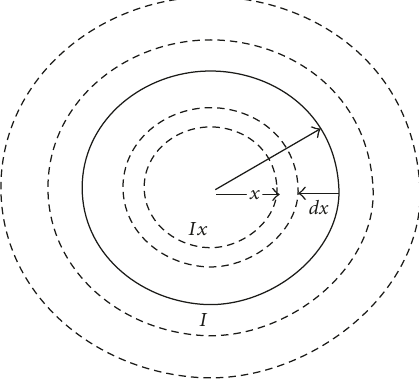
Figure 3: Magnetic field of